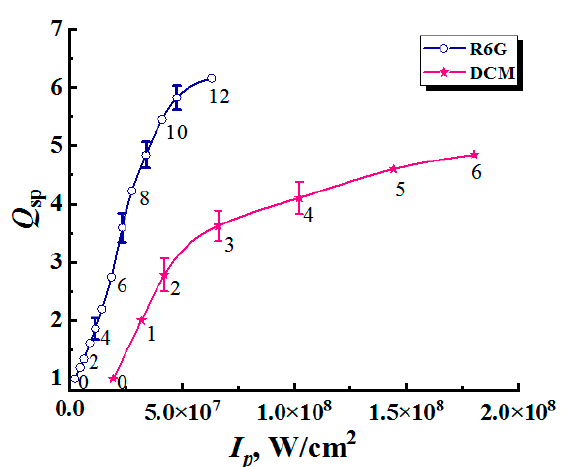
Figure 3. Q sp values against pump intensity for the R6G- and DCM-doped samples #1. Selectively shown error bars correspond to a confidence level of 0.9.